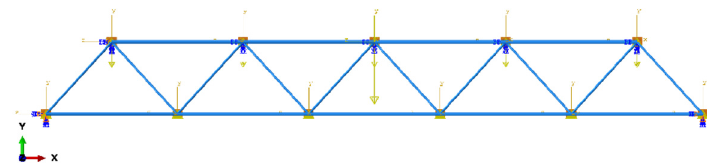
Figure 4. Test truss finite element model.